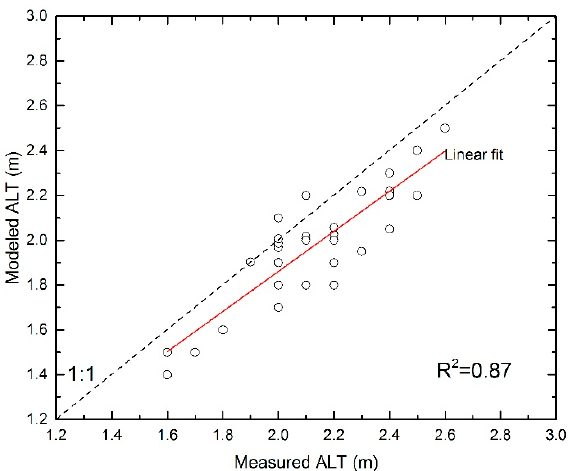
Figure 4. Scatterplot of the simulated and measured active-layer thicknesses (ALT) in di ff erent geomorphological